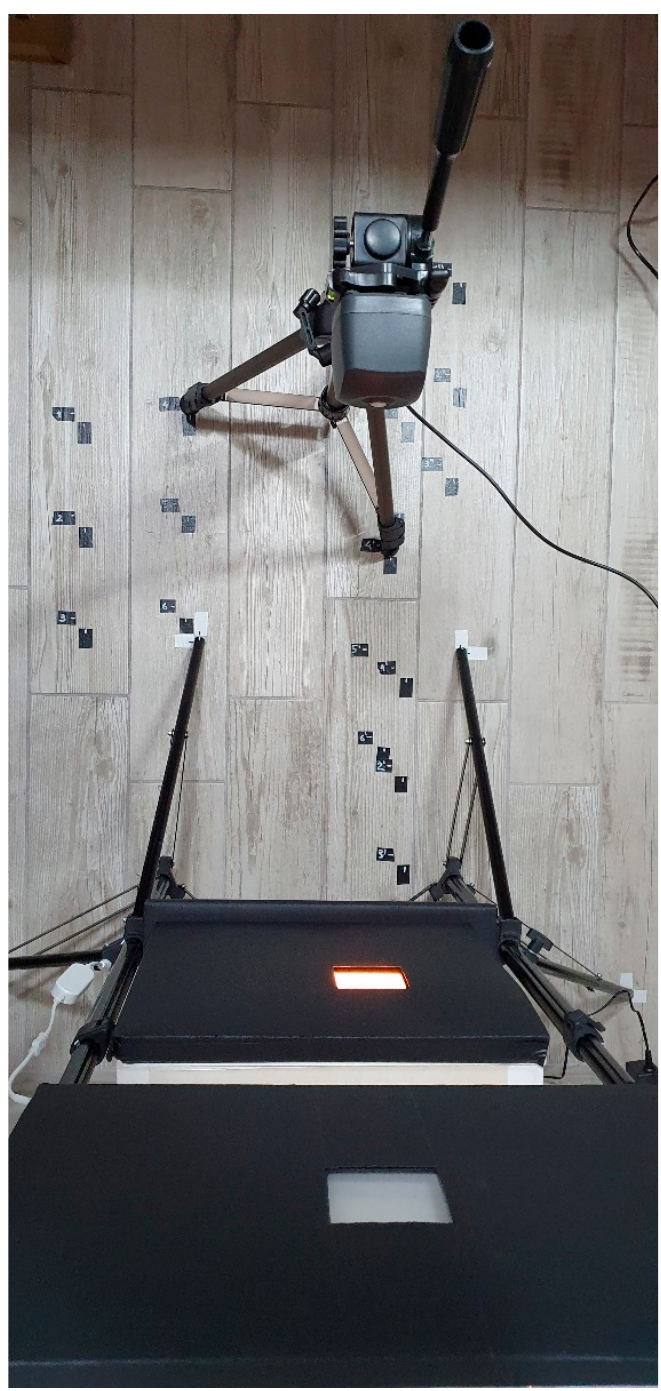
Figure 5. Plan view of the setup for acquiring the luminance mapping of the selected region of the LED panel and cube panel.